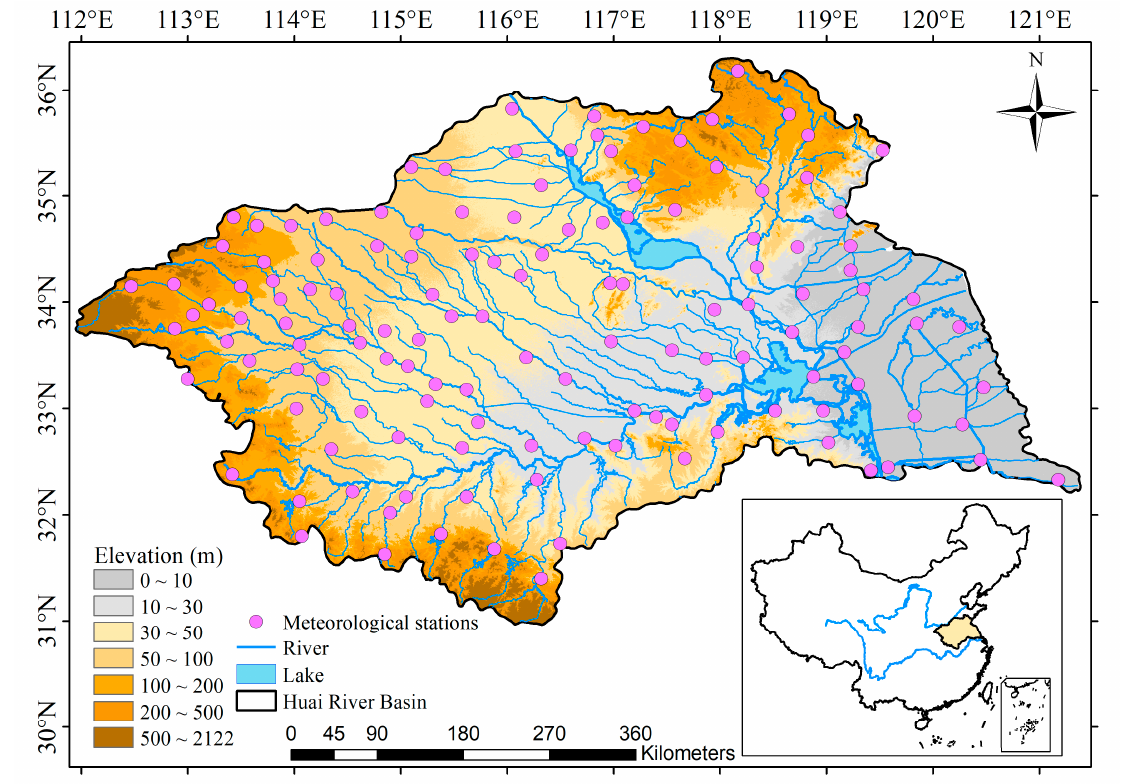
Figure 1. Location of Huai River Basin and its 135 meteorological